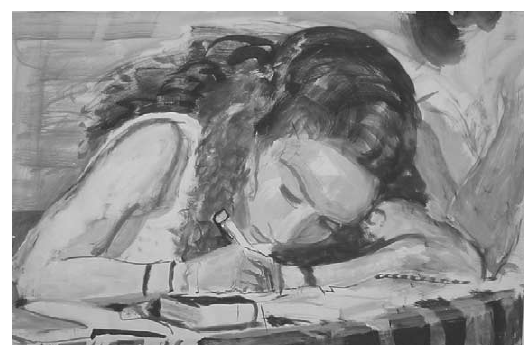
FIG. 1. A number of studies describing the application of acupuncture in inflammatory disease have been published. Conclusions are difficult to be made, due to different acupuncture techniques used and insufficiently described methodology. (Drawing by Theodoor van